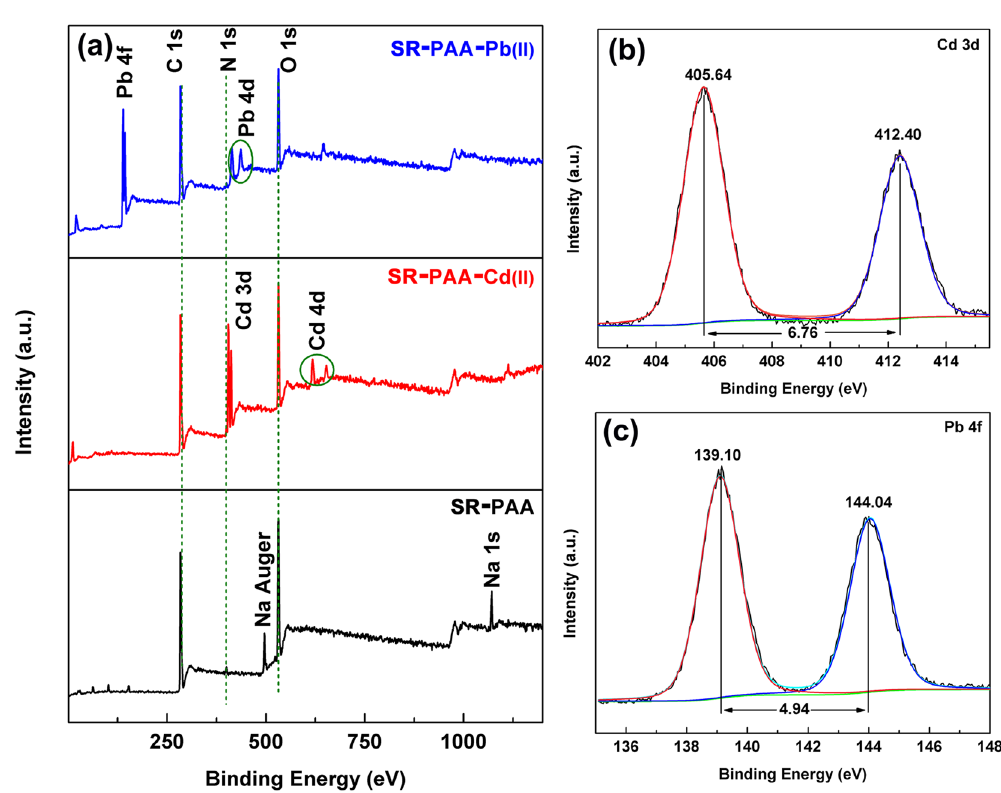
Figure 3. ( a ) XPS spectra of SR–PAA, SR–PAA–Cd and SR–PAA–Pb; XPS spectra of ( b ) Cd 3d of SR–PAA–Cd and ( c ) Pb 4 f of